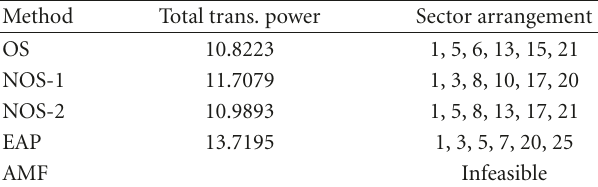
Table 6: Results for the system in Figure 9.